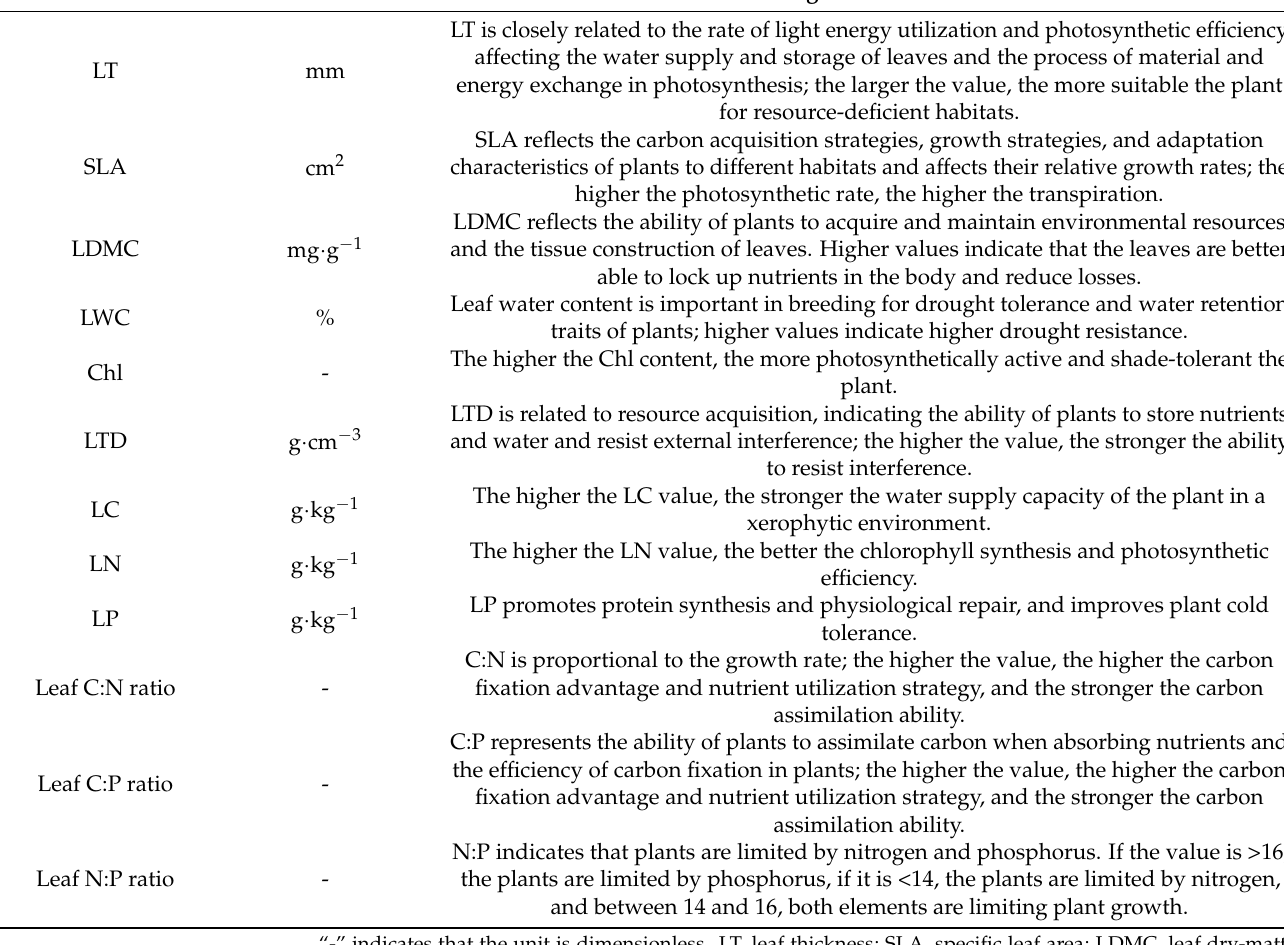
Table 3. Leaf functional traits and their ecological implications [27,28]. Trait Unit Ecological